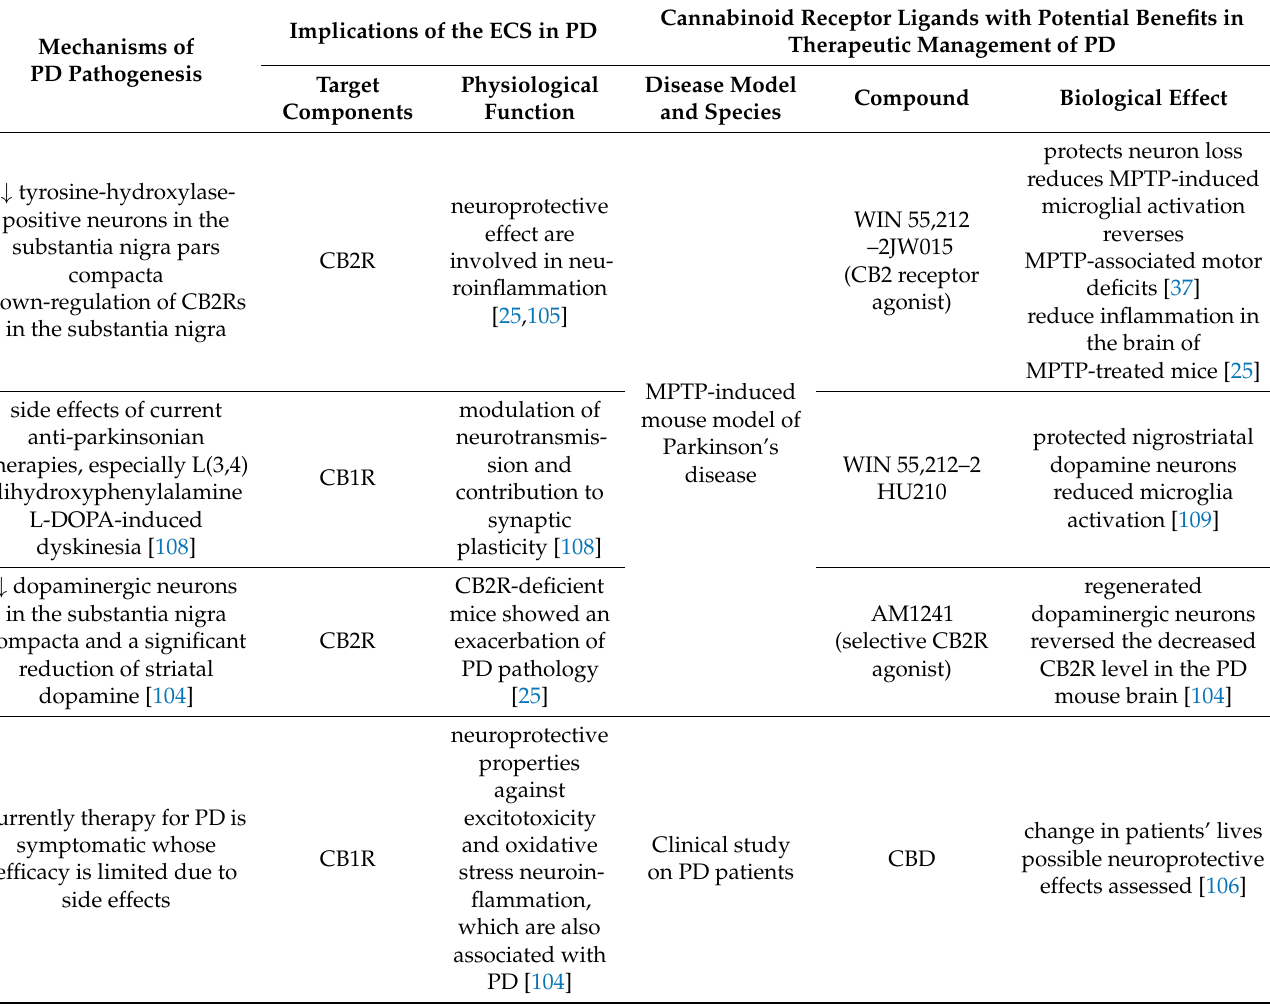
Table 2. Implications of ECS in various pathological aspects of